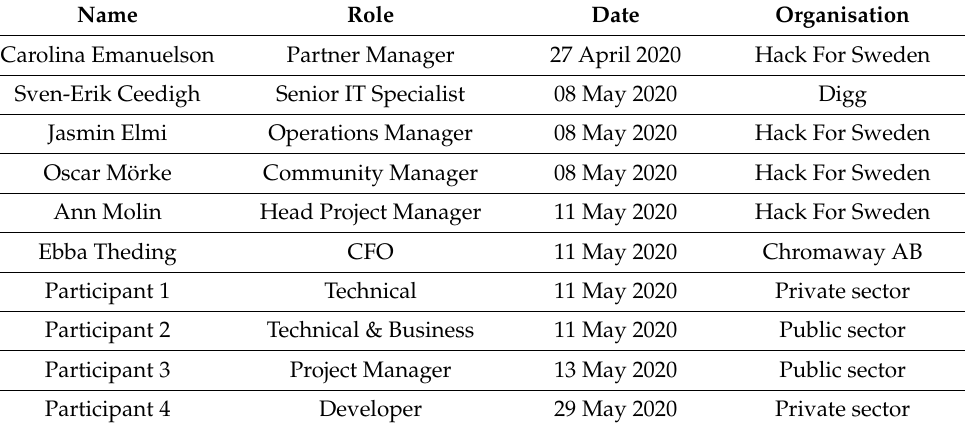
Table 2. Interview